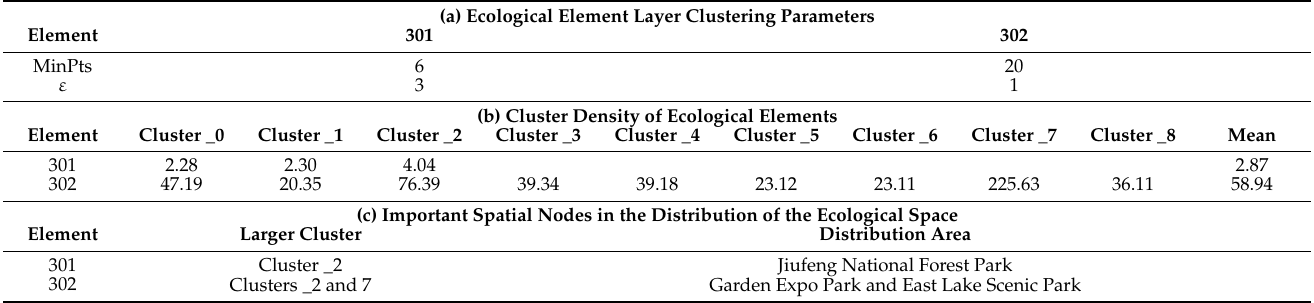
Table 6. Spatial distribution characteristics of ecological elements.